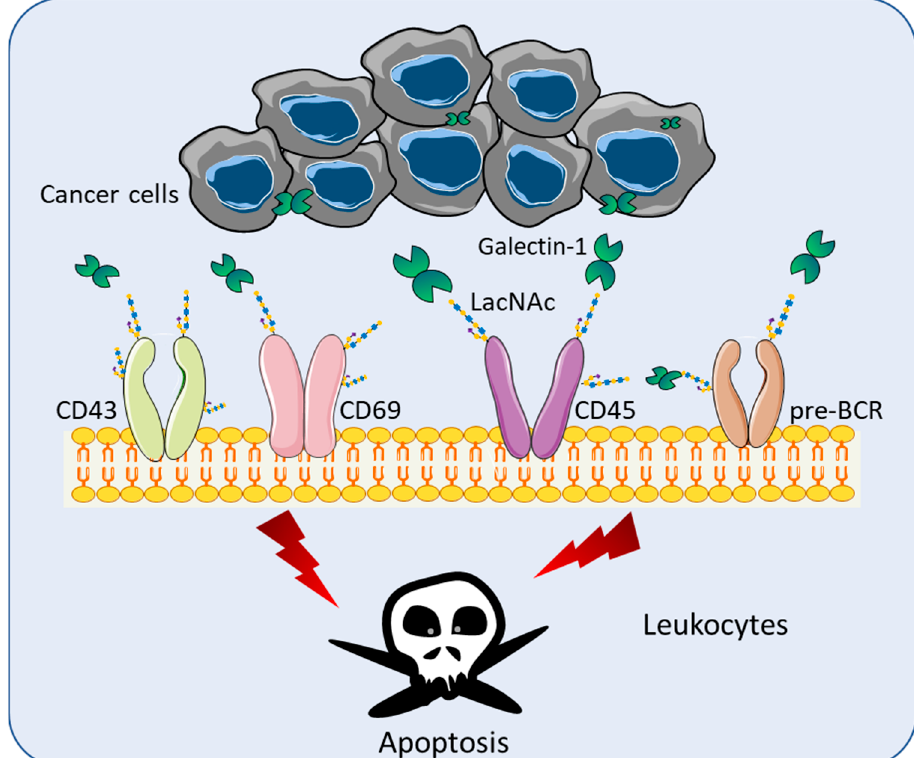
Figure 1. Immunosuppressive functions of Gal-1 in the tumor microenvironment. Gal-1 recognizes terminal galactose residues β -1,4-linked to LacNAc, which is present in different cell receptors including CD43, CD69, CD45, and pre-BCR. Through the binding of LacNAc, Gal-1 can stimulate the apoptosis of effector leukocytes.